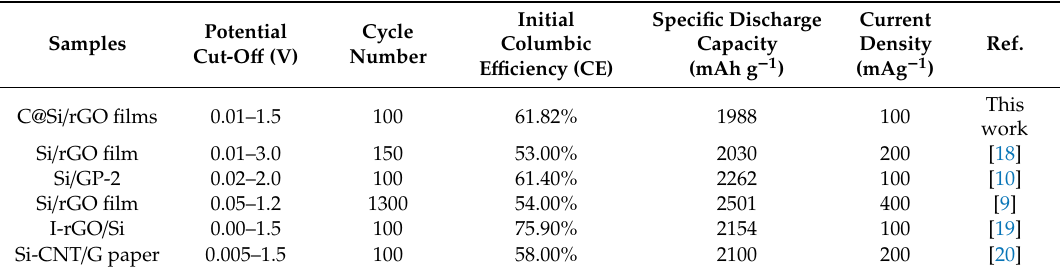
Figure S1 (a) SEM image of PDDA@Si, (b-f) EDS mapping of Si, C, O, Cl, N elements on the surface of PDDA@Si. Figure S2 Fourier transform infrared (FT–IR) spectra of KBr, Si and PDDA@Si. Figure S3 SEM images of Si / rGO (a) and C@Si / rGO (b) film electrode after 30 cycles in the lithiated